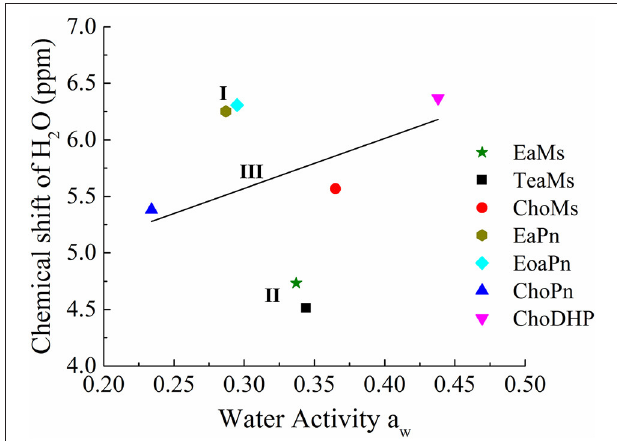
FIGURE 5 | The correlation between chemical shift of H 2 O and water activity a w of hydrated ILs (25 mol%). Region I and II refers to protic ILs with and without H 2 O peak merged with NH peak, respectively, and Region III represented aprotic ILs with linear correlation of chemical shift of H 2 O and a w , while the straight line is a guide of the tendency.